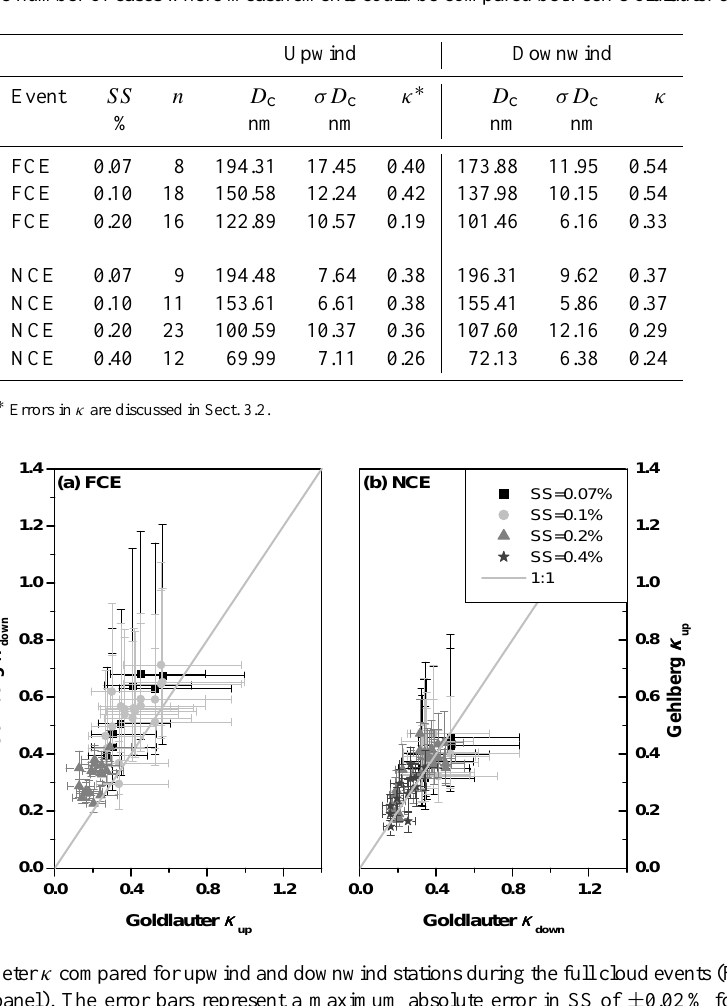
Fig. 4. Schematic depiction of the experimental mixed design. The starting and end points of the black lines refer to the critical diameter data points.